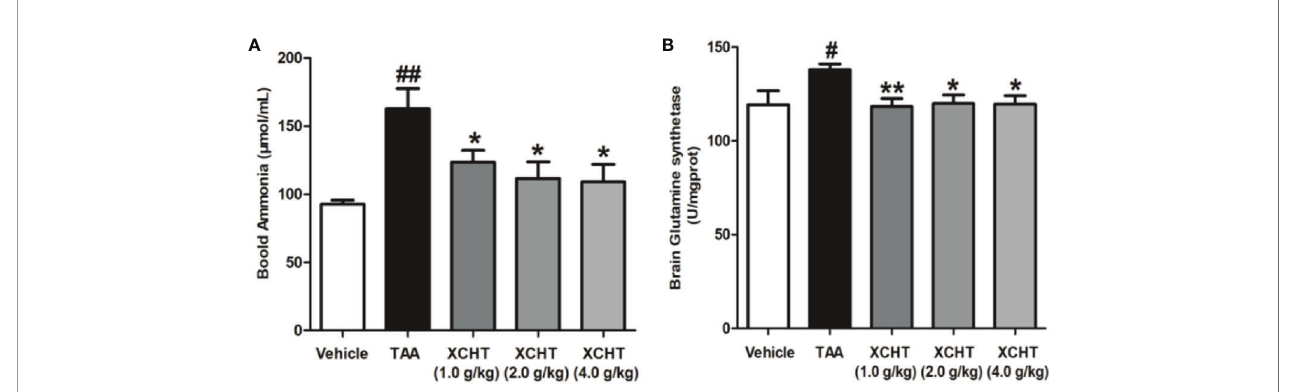
FIGURE 2 | Effect of XCHT on ammonia level in TAA induced AHE rats. (A) Ammonia plasma levels in all groups of rats. (B) GS levels in cerebral cortex of rats. Data were expressed as mean ± SD (n = 5-7). # p < 0.05, ## p < 0.01 vs. the vehicle group. *p < 0.05, **p < 0.01 vs. the